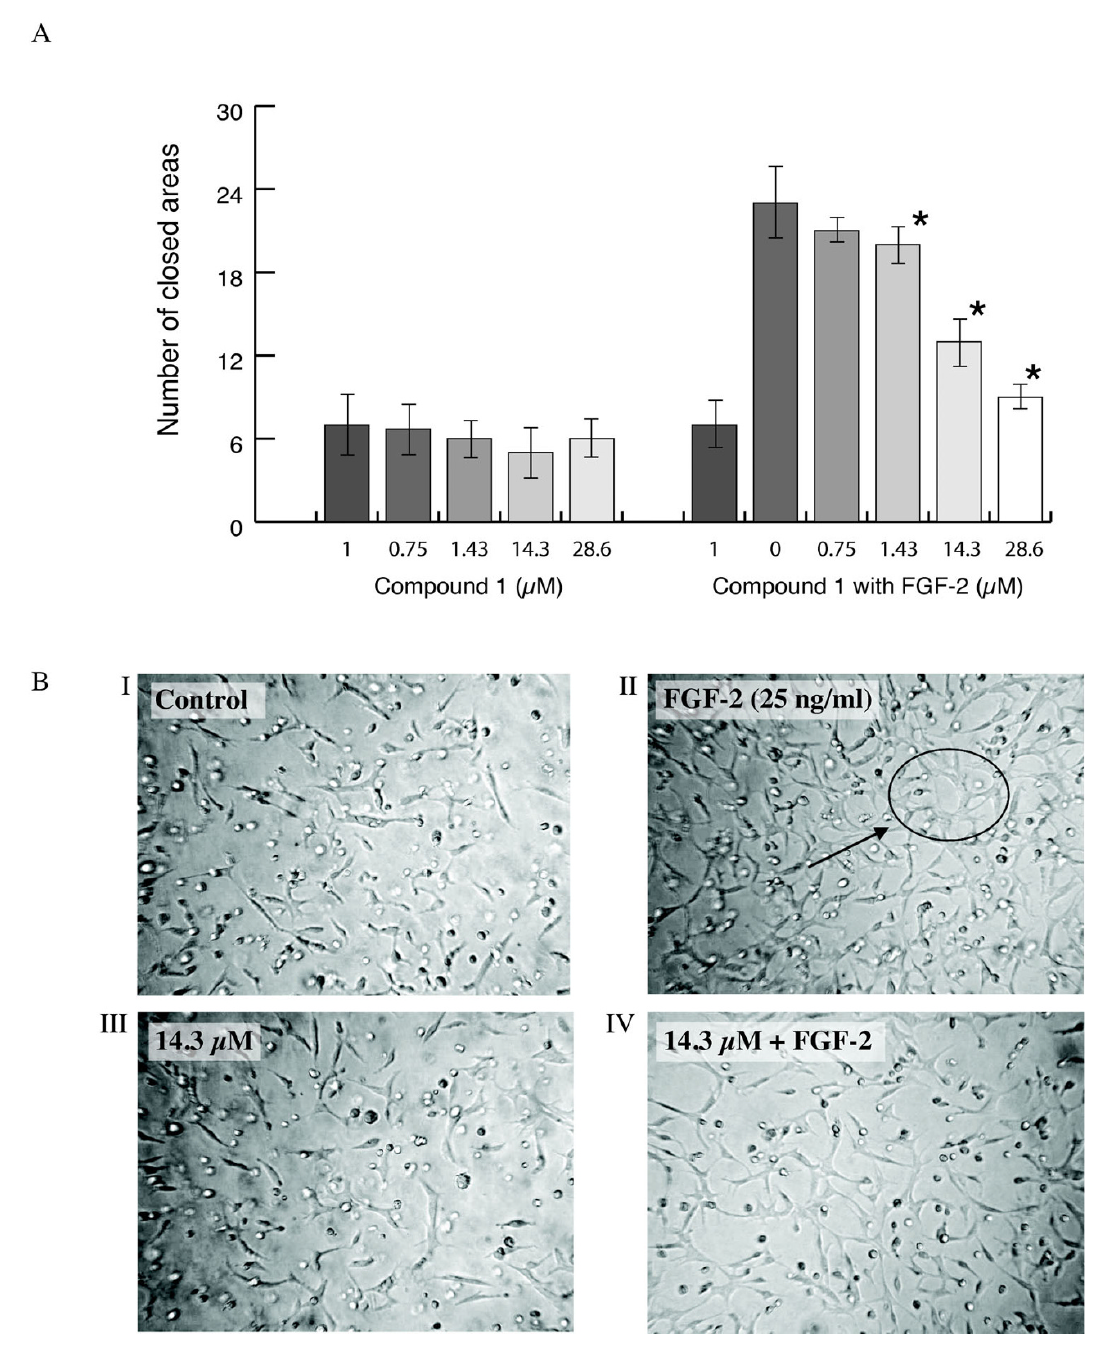
Figure 5 The effect of compound 1 on BAEC tube formation in Matrigel with and without FGF-2 . (A) Compound 1 inhib- ited FGF-2 (25 ng/ml) induced BAEC differentiation into capillary like structures: column1, control. In the absence of FGF-2 there was no inhibitory effect on tube formation. Values significantly different from FGF-2 alone (p < 0.05) are shown by *. Results are the mean of three experiments (B) Representative photomicrographs (original magnification × 20) show tube for- mation by BAEC. In the presence of FGF-2 a closed tubular network was evident (an example is shown in II) and this was abol- ished by compound 1 (shown in IV). In the control (I0 and with compound 1 alone (III) there was no evidence of tube